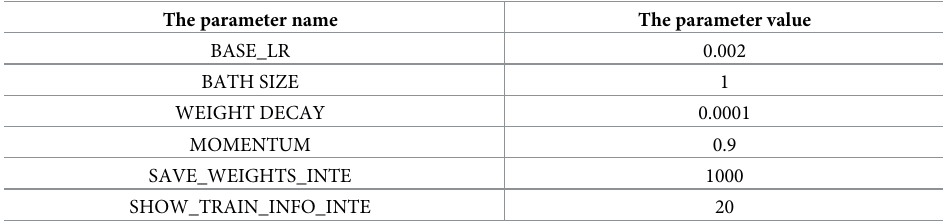
Table 3. Parameter setting table for training feature extraction